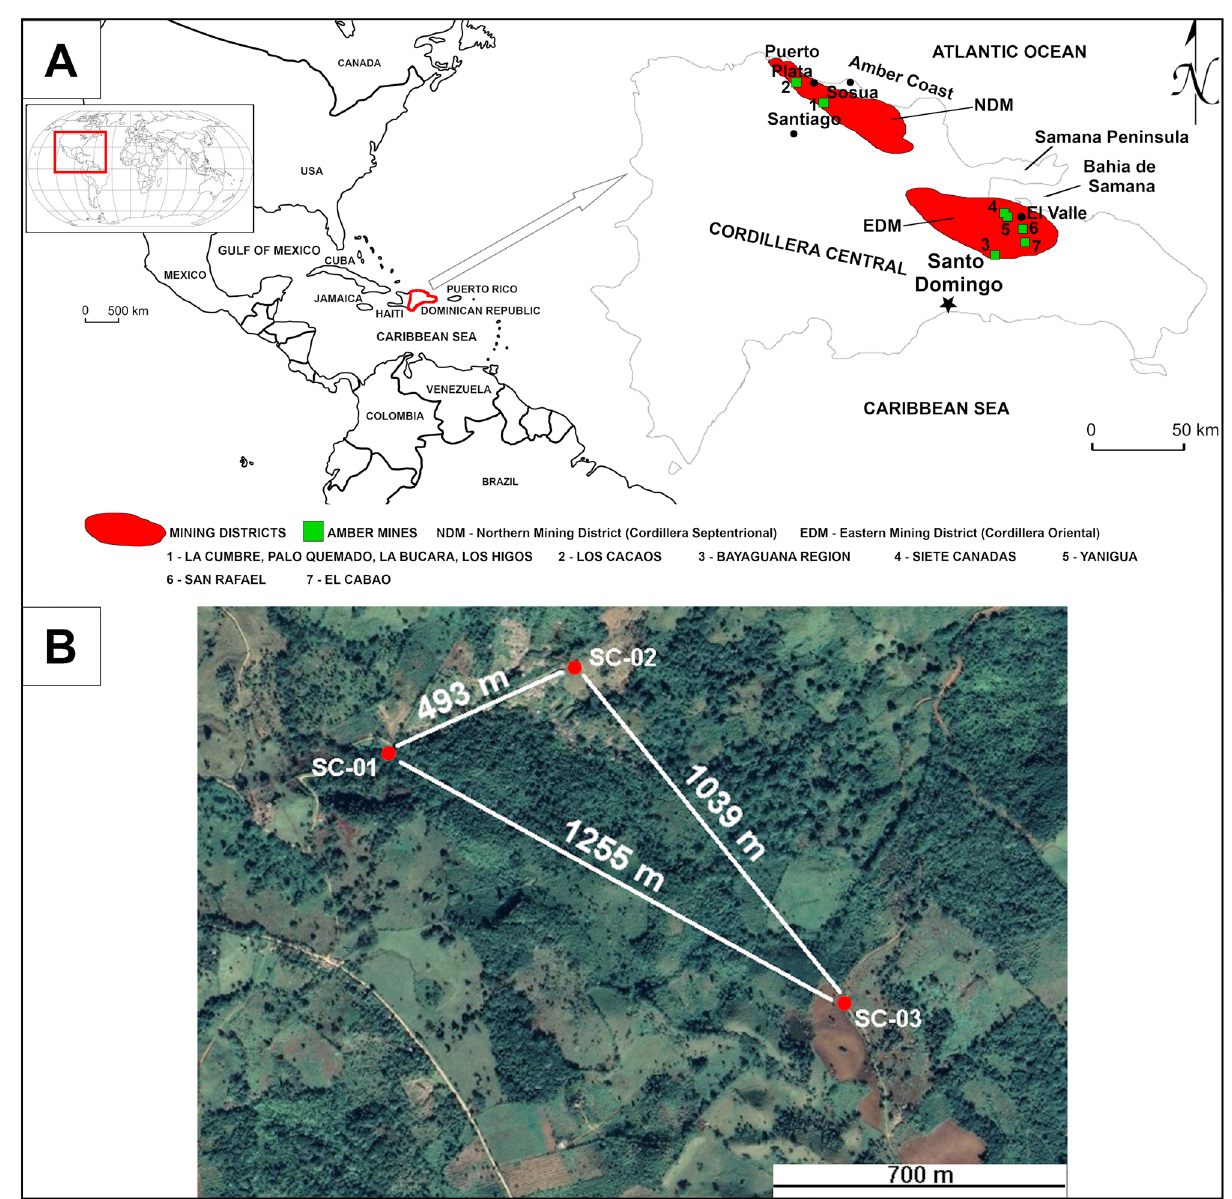
Figure 1. ( A ) Sketch map of the Dominican Republic with the location of the main amber deposits 10 . ( B ) Orthophoto map showing the orientation of the boreholes and distances between boreholes in the Siete Cañadas zone. ( A ) was drawn using CorelDRAW X5 and URL link is https:// www. corel draw. com/. ( B ) was generated using Google Earth 9.140.0.4 software and URL link is https:// earth. google.